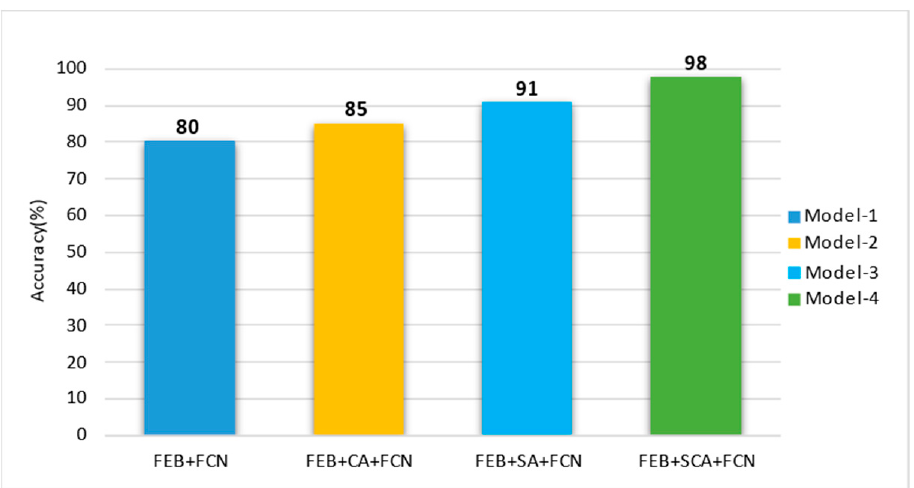
Figure 4. Classification performance comparison of our developed CNN models. All CNN models were trained to classify the 3D ball joint socket product into defective and non-defective categories.